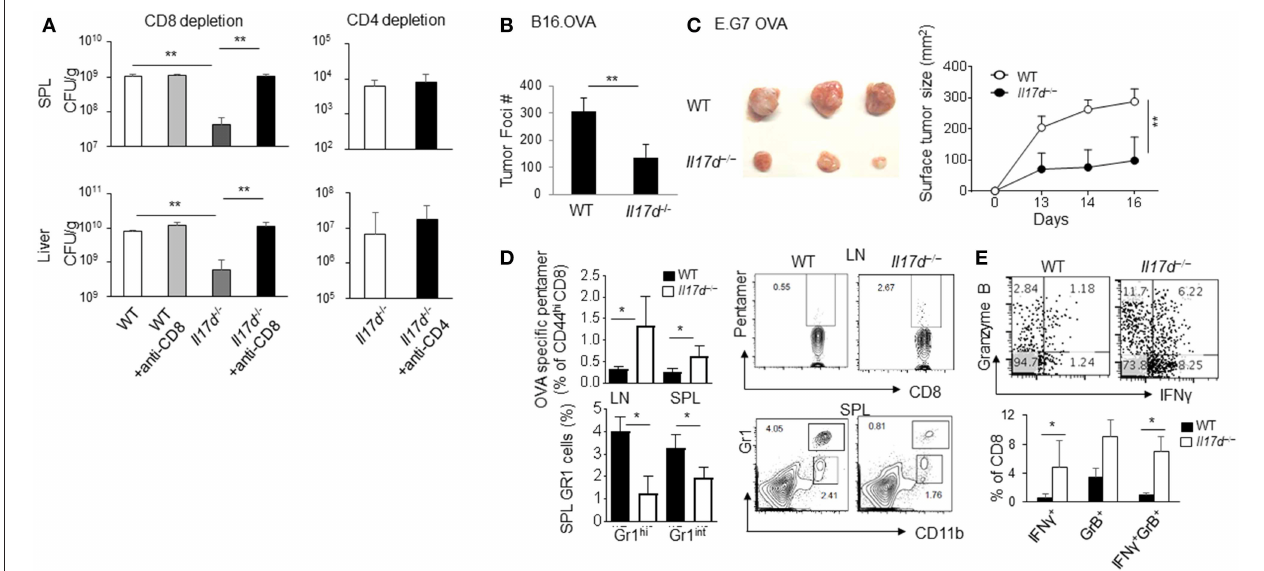
FIGURE 4 | IL-17D promotes chronicity of LM-OVA infection by suppressing CD8T cells, not CD4T cells. (A) WT ( n = 4) or Il17d − / − mice ( n = 4) were intravenously infected with 1 × 10 4 LM-OVA. Anti-CD8 (536.7) and anti-CD4 (GK1.5) mAb were injected 1 and 3 days before the bacterial challenge. Bacterial burden was counted on day 7. (B) B16 OVA melanoma cells were intravenously injected into WT ( n = 5) or Il17d − / − ( n = 4) mice. After 14 days, mice were killed, and the tumor burdens were counted. (C) E.G7 OVA lymphoma cells were subcutaneously injected into WT ( n = 3) or Il17d − / − ( n = 3) mice. After 16 days, mice were killed, and their tumor size and tumor weight were measured. (D) OVA-specific pentamer-positive cells in CD8T cells in spleens and lymph nodes. Gr1 hi CD11b + and Gr1 int CD11b + gated cell percentages in the spleen and lymph nodes. (E) Production of granzyme B and IFN γ in CD8T cells in tumor infiltrating lymphocytes by intracellular staining. Data are representative of at least two or three independent experiments. * p ≤ 0.05, ** p ≤ 0.01.